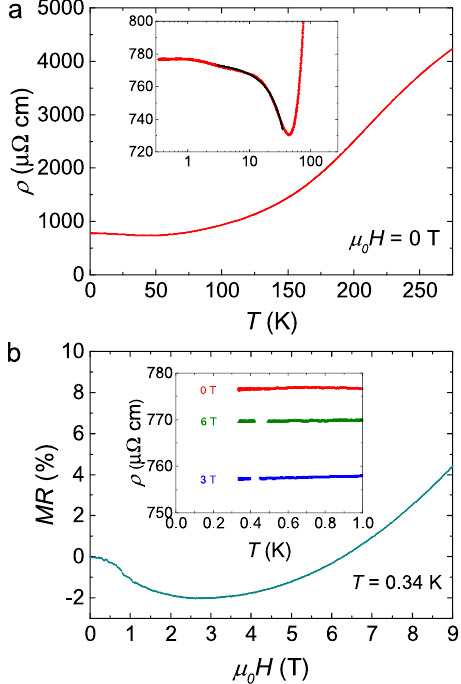
Fig. 1 Charge transport results of Pr 2 Ir 2 O 7 . a Temperature dependence of the resistivity at zero fi eld for Pr 2 Ir 2 O 7 single crystal. Inset: zoomed view of the resistivity minimum at 45 K due to the Kondo effect. The solid line is the fi t to Hamann equation between 3 K and 35 K. b The magnetoresistance at T = 0.34 K. The magnetic fi eld is applied along the [111] direction. Inset: ρ ( T ) below 1 K in µ H = 0, 3, and 6 0